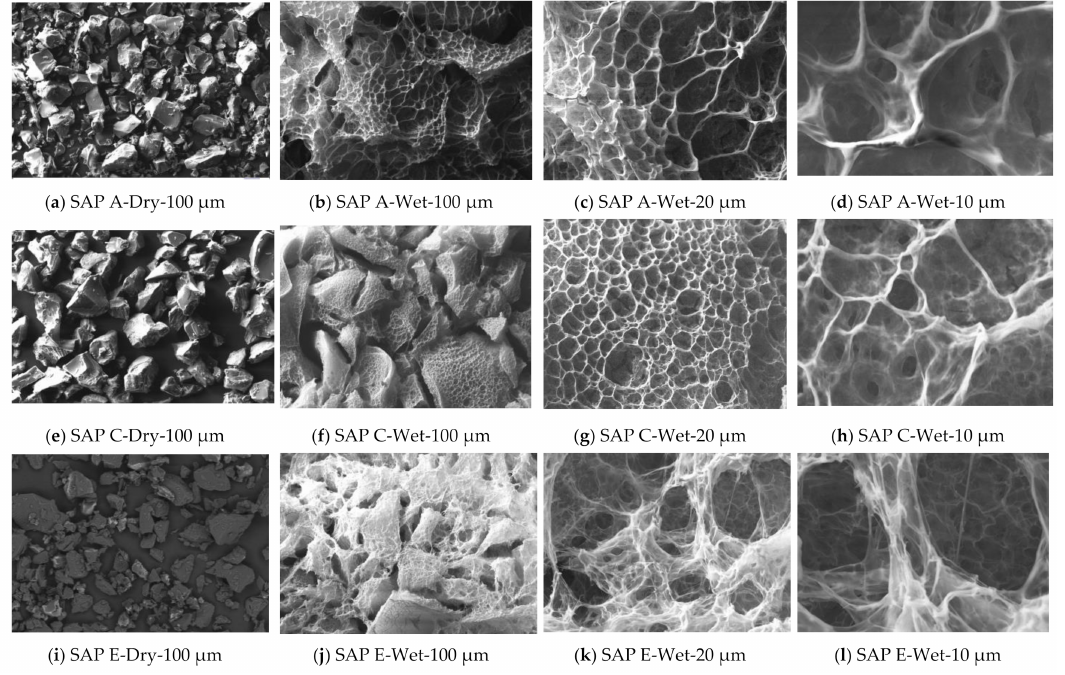
Figure 7. SEM of SAPs in dry and wet conditions; SAP A ( a – d ), SAP C ( e – h ), and SAP E ( i – l